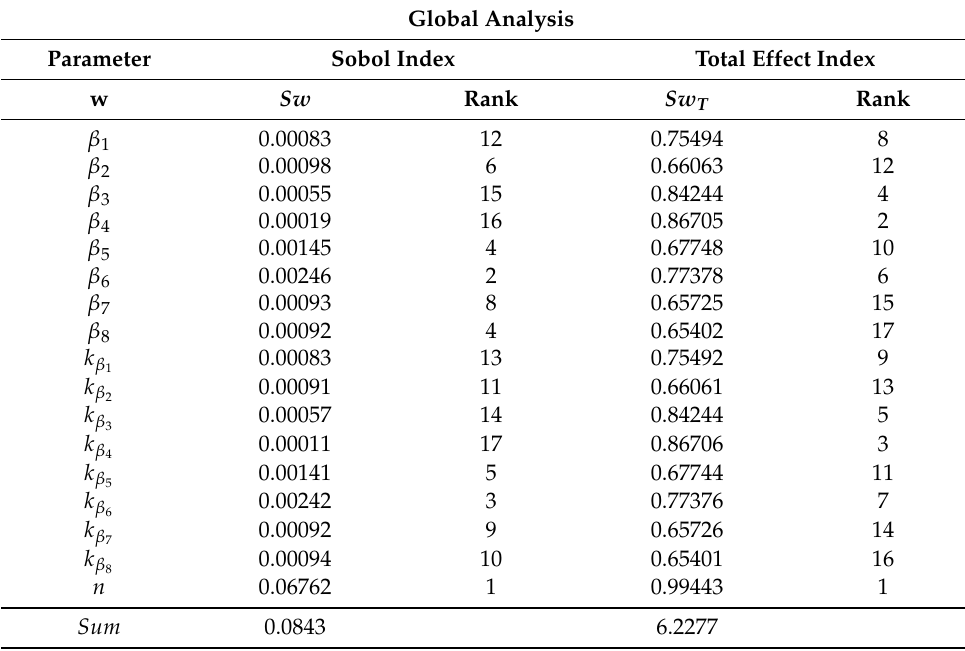
Table 2. Parameter sensitivity ranking of the EEGBW